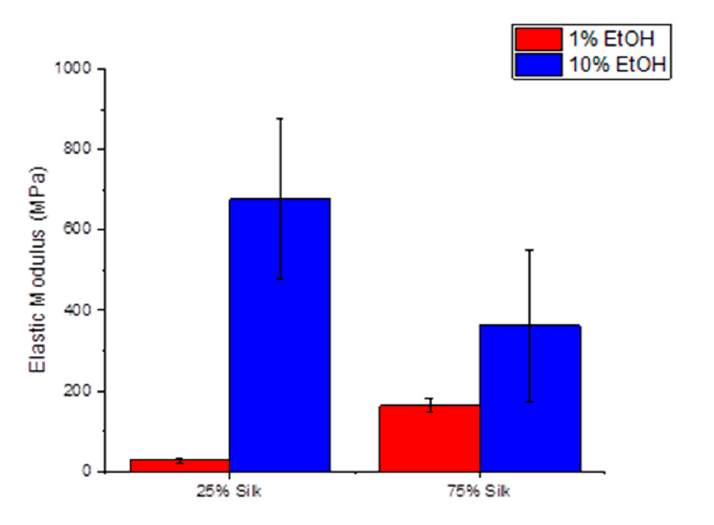
Figure 7. Elastic modulus of the two sets of varied composition silk/cellulose biocomposites coagulated with two different percentages of ethanol.